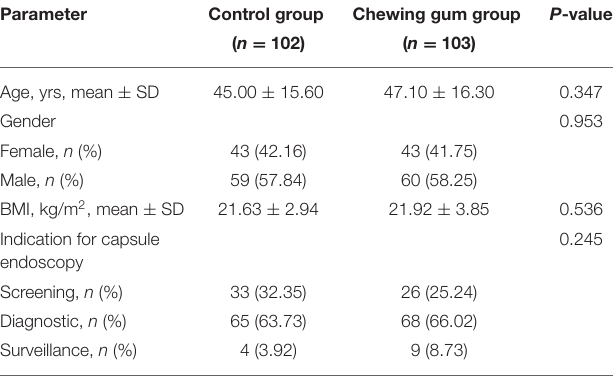
TABLE 1 | Characteristics of the study subjects.